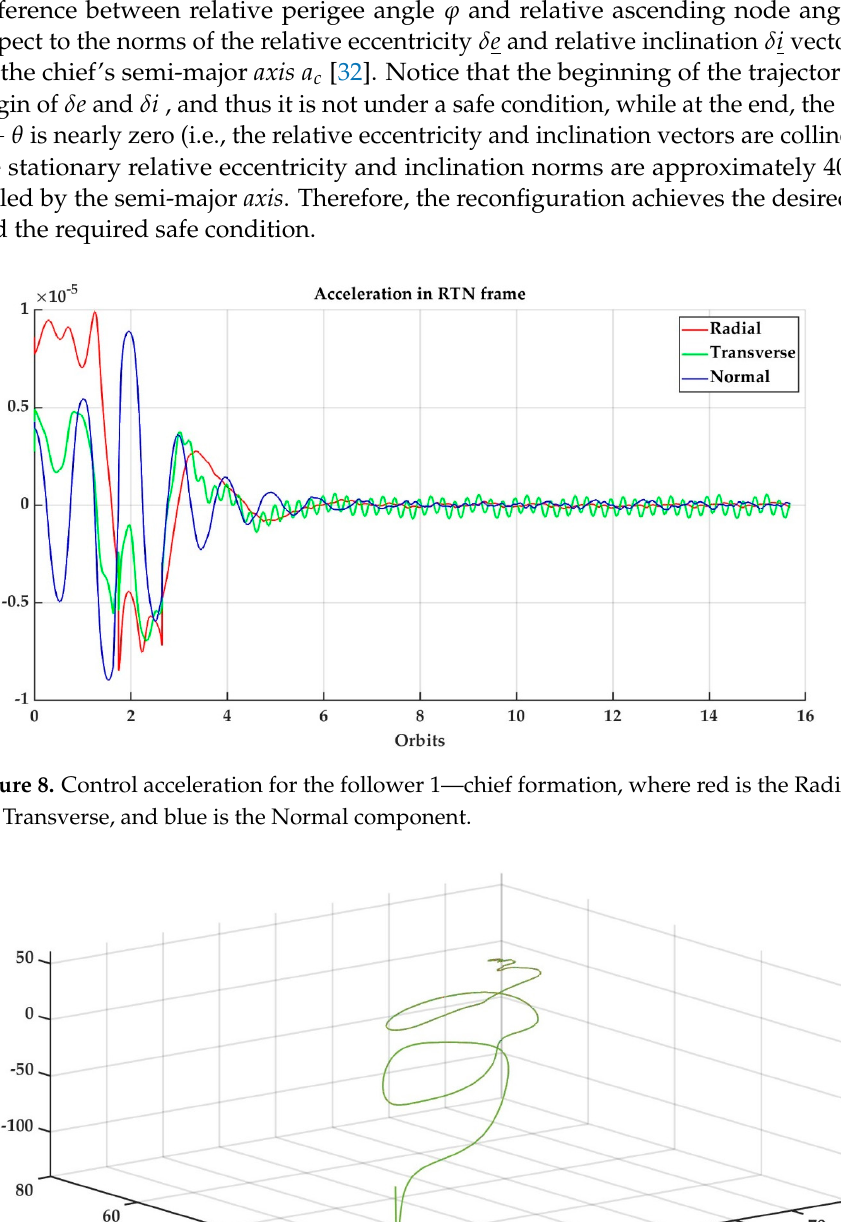
Figure 7. ( A ) Simulation of a Robust Multibaseline AT-InSAR formation for follower 1. ( a ) Shows the components of 𝛿𝑒 and 𝛿𝑖 , ( b ) shows the 𝛿𝑟 (cid:3045)(cid:3041)(cid:3040)(cid:3036)(cid:3041) and ( c ) shows the along track separation be- tween follower 1 and the chief. ( B ) Simulation of a Robust Multibaseline AT-InSAR formation for follower 2. ( a ) Shows the components of 𝛿𝑒 and 𝛿𝑖 , ( b ) shows the 𝛿𝑟 (cid:3045)(cid:3041)(cid:3040)(cid:3036)(cid:3041) and ( c ) shows the along track separation between follower 2 and the chief.